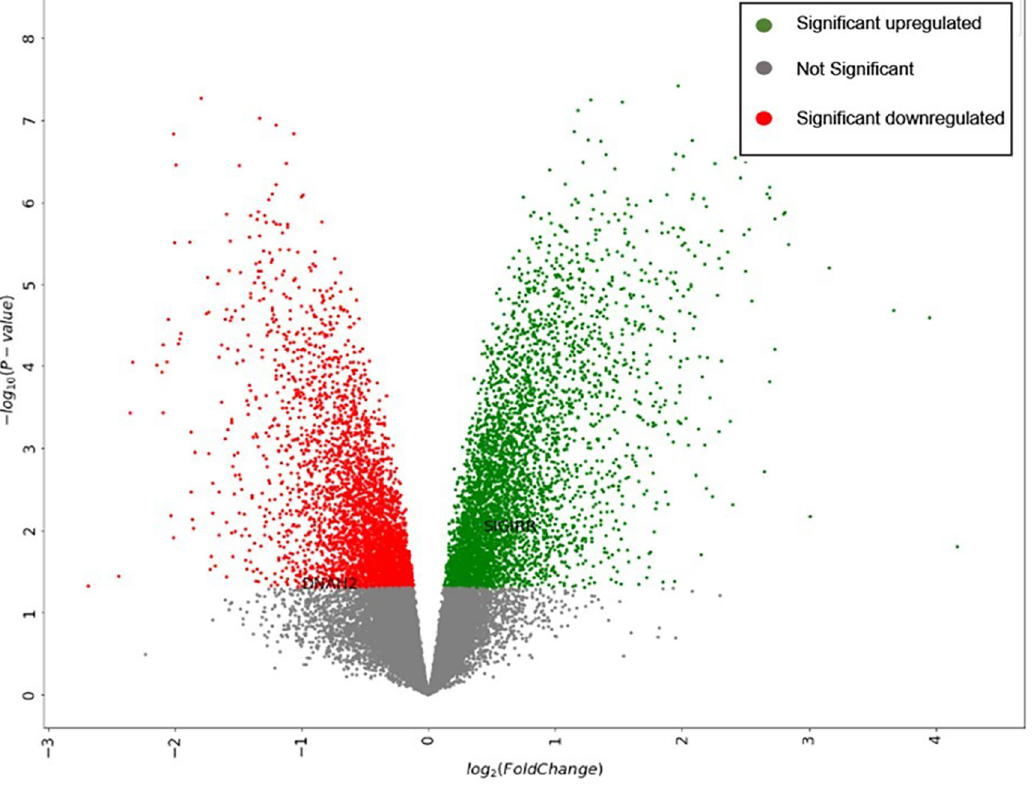
Figure 2. Volcano plot generated by the “ Gene expression data visualization ”